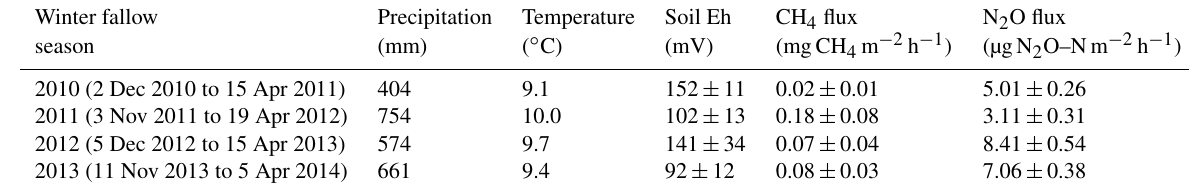
Table 4. Total precipitation, mean daily temperature, mean ∗ soil Eh, CH 4 , and N 2 O fluxes over the four winter fallow seasons. Winter fallow Precipitation Temperature Soil Eh CH 4 flux